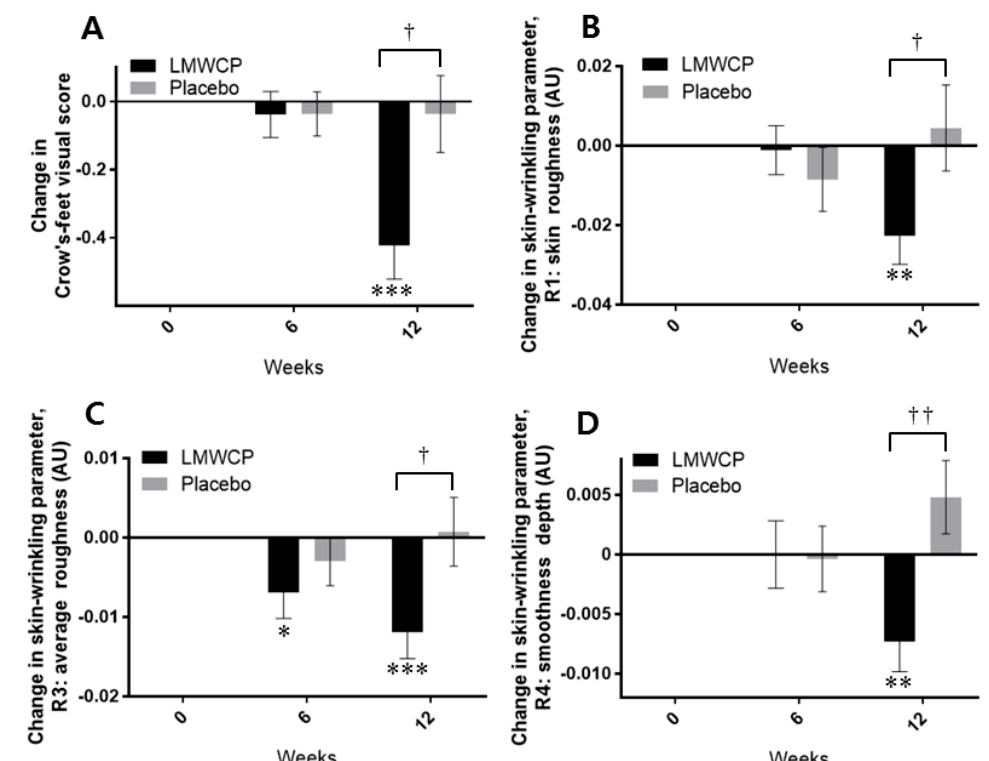
Figure 3. Changes in skin-wrinkling parameters in individuals receiving Low-molecular-weight Collagen peptide (LMWCP) preparation or placebo. ( A ) Changes in visually assessed Crow’s-feet scores. ( B ) Changes in skin-wrinkling parameter R1 (skin roughness). ( C ) Changes in skin-wrinkling parameter R3 (average roughness). ( D ) Changes in skin-wrinkling parameter R4 (smoothness depth). R1, R3, and R4 were measured instrumentally with a Skin Visiometer SV600. Changes in parameter values from baseline are shown in arbitrary units (AU). Data are expressed as the mean ± SEM. * p -values for t -test comparisons with baseline values; * indicates p < 0.05, ** indicates p < 0.01, *** indicates p < 0.001. † p -values for t -test comparisons between values in the test group and the placebo group; † indicates p < 0.05, †† indicates p < 0.01.